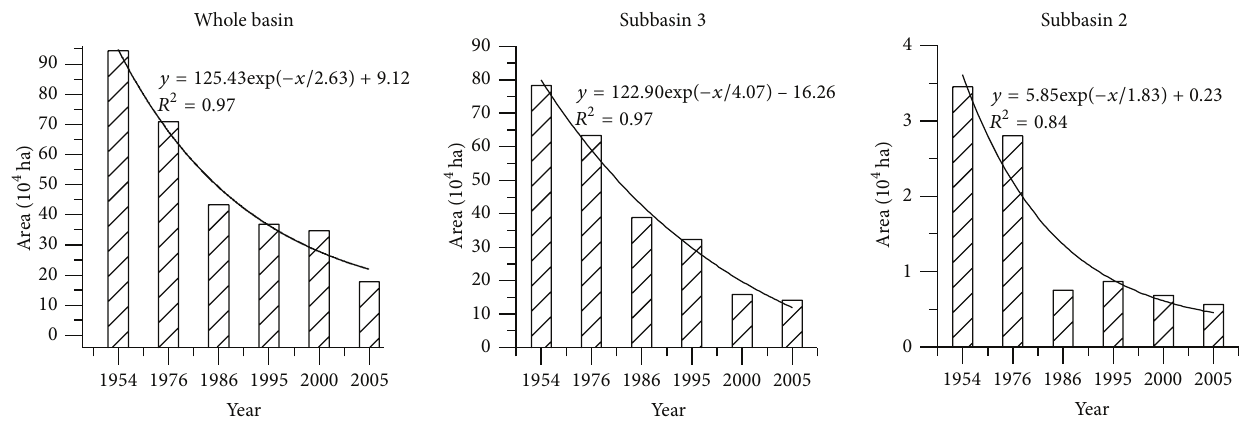
Figure 2: Wetlands cultivation in the whole basin, subbasin 2, and subbasin